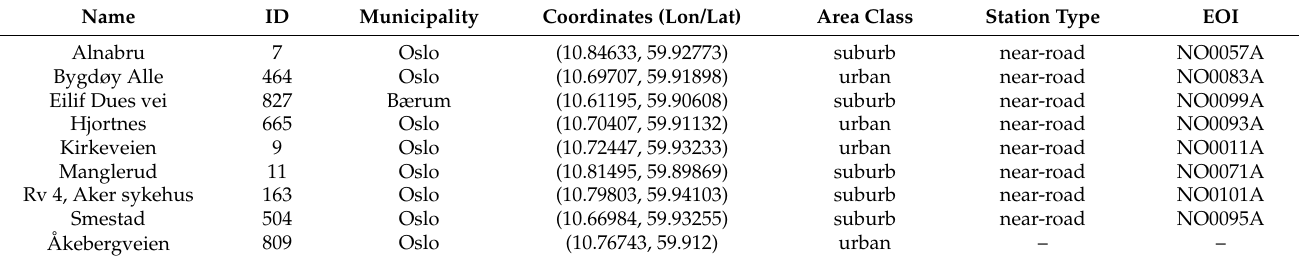
Table 1. Metadata of the nine monitoring stations measuring NO 2 located in the metropolitan region of